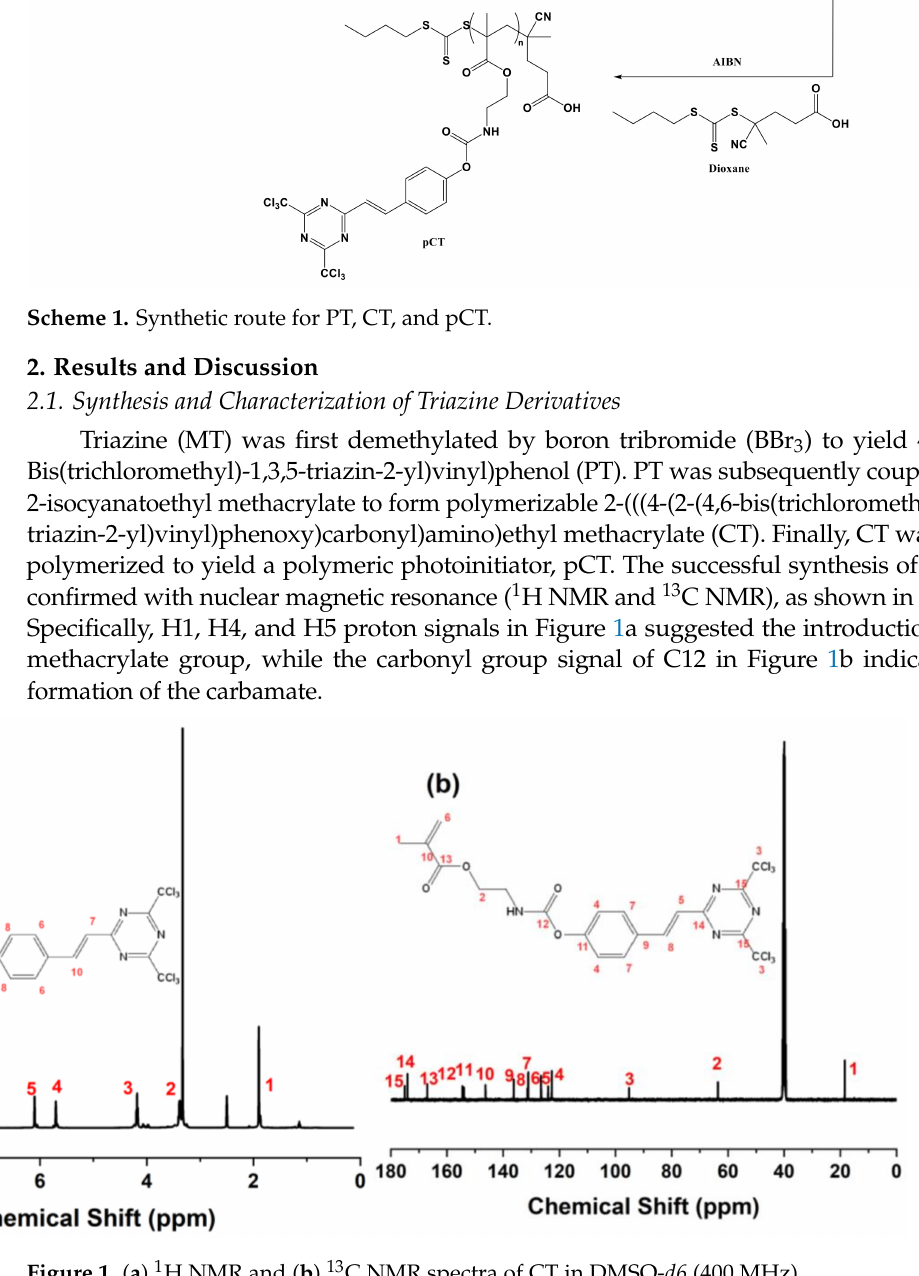
Figure 1. ( a ) 1 H NMR and ( b ) 13 C NMR spectra of CT in DMSO- d6 (400